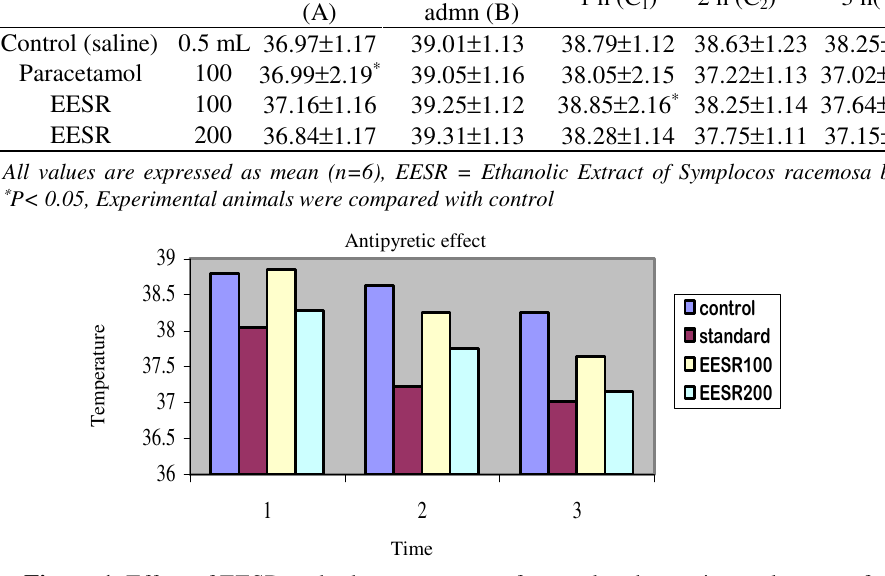
Figure 1. Effect of EESR on body temperature of control and experimental group of rats